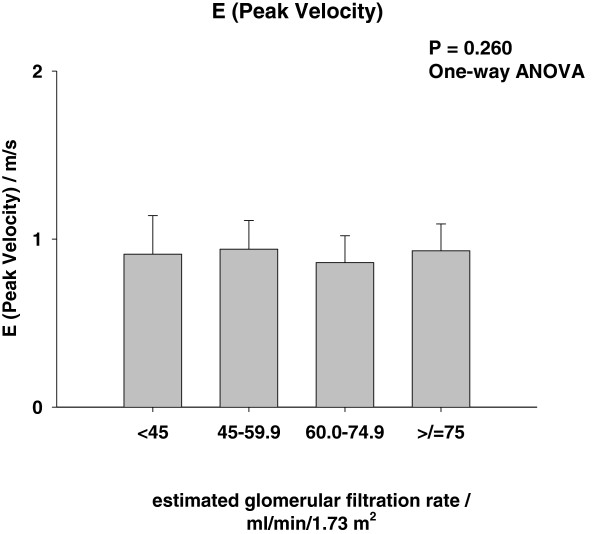
E (peak velocity) and frequency of restrictive filling pattern.